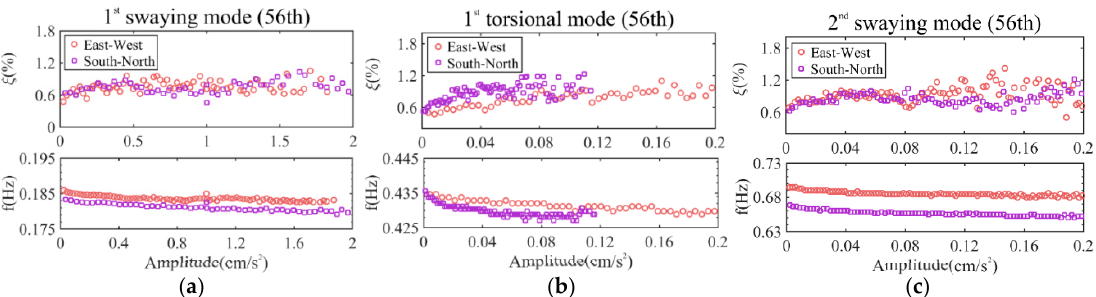
Figure 14. Amplitude-dependence of natural frequencies and damping ratios for the first two swaying modes and the first torsional mode along two measurement directions. ( a ) 1 st swaying mode; ( b ) 1 st torsional mode; ( c ) 2 nd swaying mode.